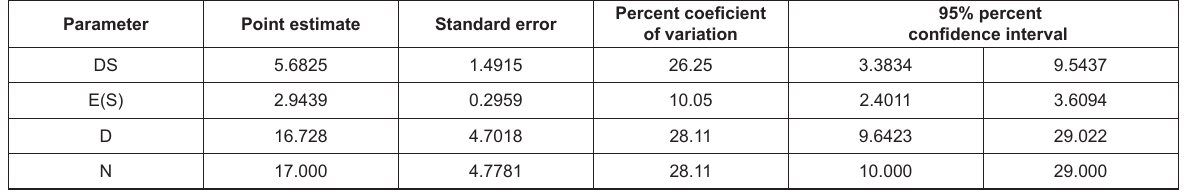
Table 1. Population density and average group size of Grey Junglefowl ( Gallus sonneratii ) in Melghat Tiger Reserve, Maharashtra (October 2010 to March 2011). Parameter